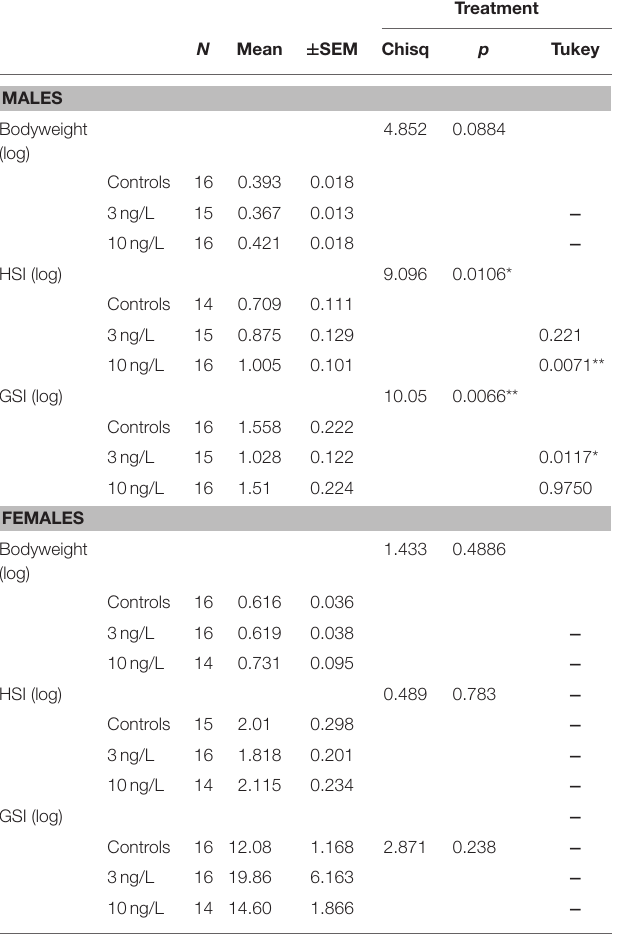
TABLE 2 | Bodyweight, hepatosomatic index (HSI), and gonadosomatic index (GSI) in male and female zebra fish developmentally exposed to EE 2 after 120 days of remediation. Treatment vs. controls analyzed with Tukey contrasts.